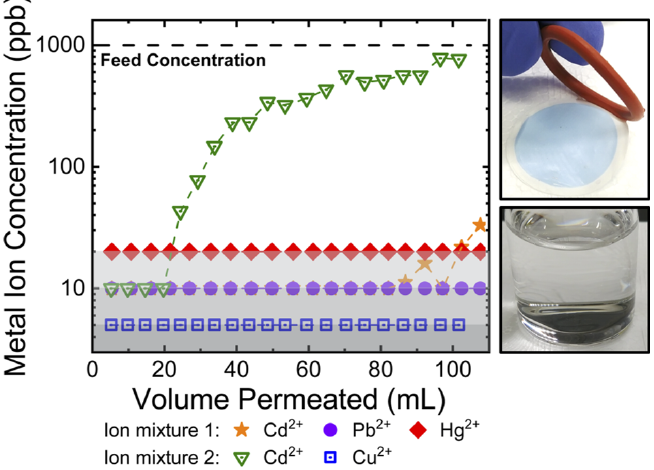
Figure 17. Dynamic breakthrough experiments demonstrating metal ion removal in pressure-mediated flow. Reproduced from [168], used under CC-BY 4.0.